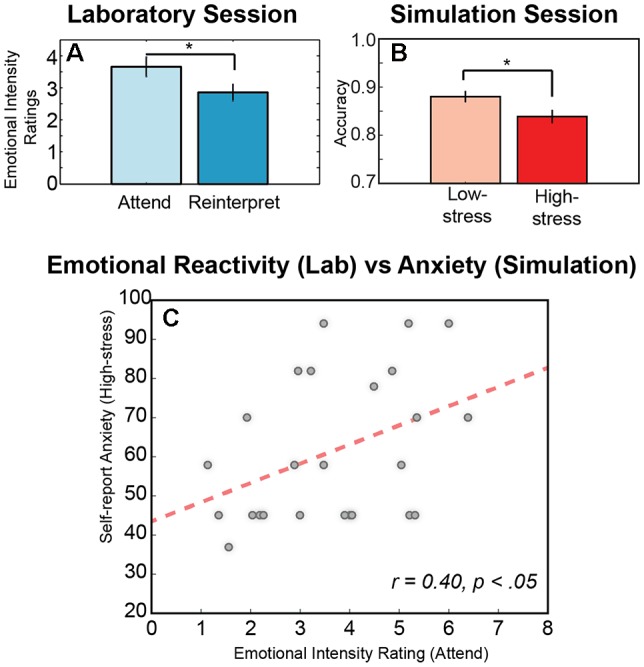
Behavioral responses across sessions. (A) Significant difference in the mean intensity ratings for the negative military affective picture system (MAPS) images averaged across conditions (attend, reinterpret) and across participants. (B) Significant difference in the mean accuracy for the immersive shooting task averaged across conditions (low-stress, high-stress) and across participants. (C) Significant relationship between emotional intensity rating during the attend condition of the laboratory emotion regulation task and the self-report anxiety score after the high-stress in the simulation environment. An * indicates significance in a pair wise t-test (p < 0.05), and error is indicated as SEM across participants.